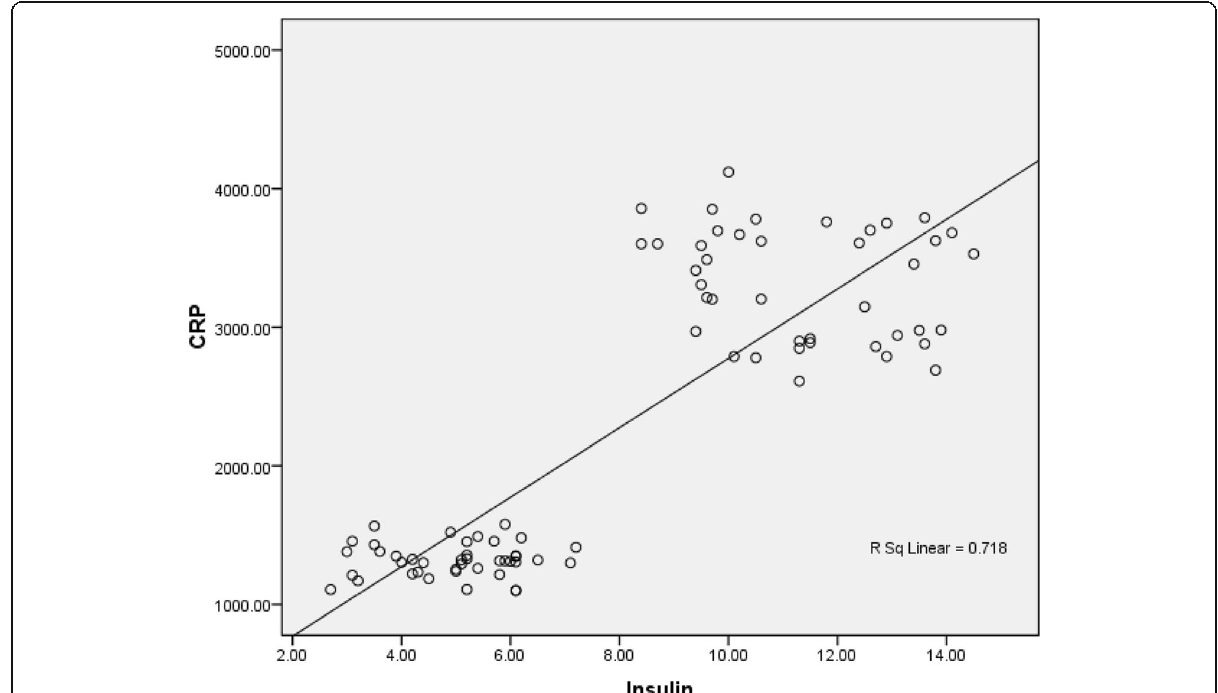
Fig. 5 Scatter diagram showing positive correlation between CRP and insulin